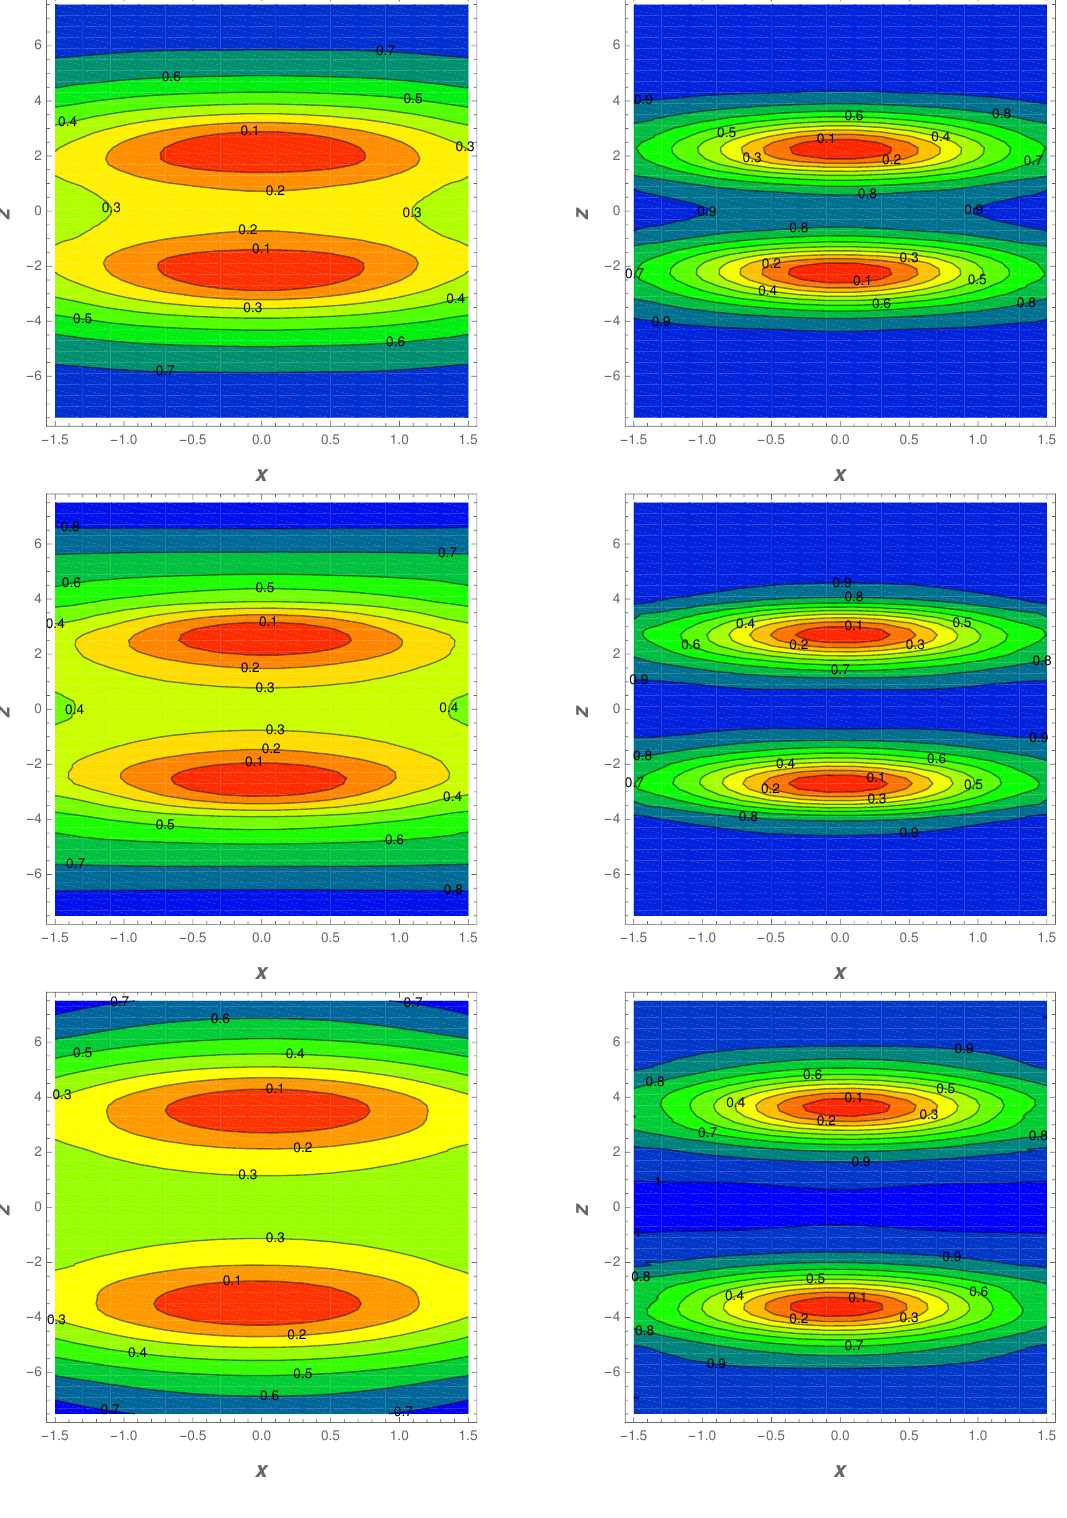
Figure 4 . The sum in quadrature of the three gauge components of scalar (cid:12)eld I = 1 (left) and I = 2 (right) at t = 3 (top), t = 6 (middle) and t = 15 (bottom). The (cid:12)nely spaced grid is